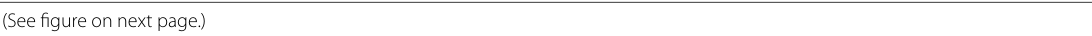
(sub)species(See figure on next Fig. 3 Distribution of β-galactosidases selected for functional assessment across the five bifidobacterial reference strains. a Similarity plot showing the percentage of similarity of the 20 selected β-galactosidases across the reference strains (cut-off of 70% of identity over 90% of protein length). For each gene the relative cluster of appartenance from comparative genomics is also indicated. b Hierarchical clustering analysis showing the co-occurrence of the 20 selected β-galactosidases and their cluster of orthology across the reference genomes and bifidobacterial